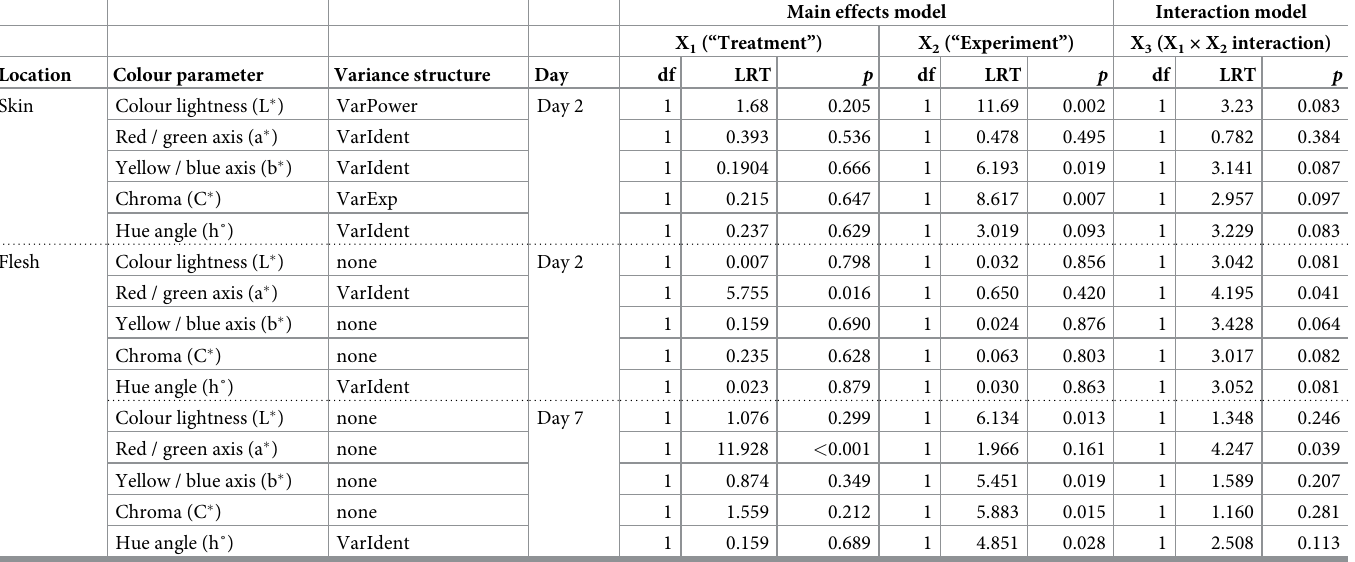
Table 5. Skin and flesh colour statistical results. Statistical test results and associated significance of the interactive and main effect of “treatment” (either control or crowded) and “experiment” (either E19, E20 or net pen) on mackerel skin and flesh colour parameters. Colour was assessed after two (“Day 2”) and/or seven days (“Day 7”) of ice storage. Skin models were fitted using Generalized Least Squares (GLS) regression. Flesh models were fitted using linear mixed effects models (LMM). The applied variance structure is